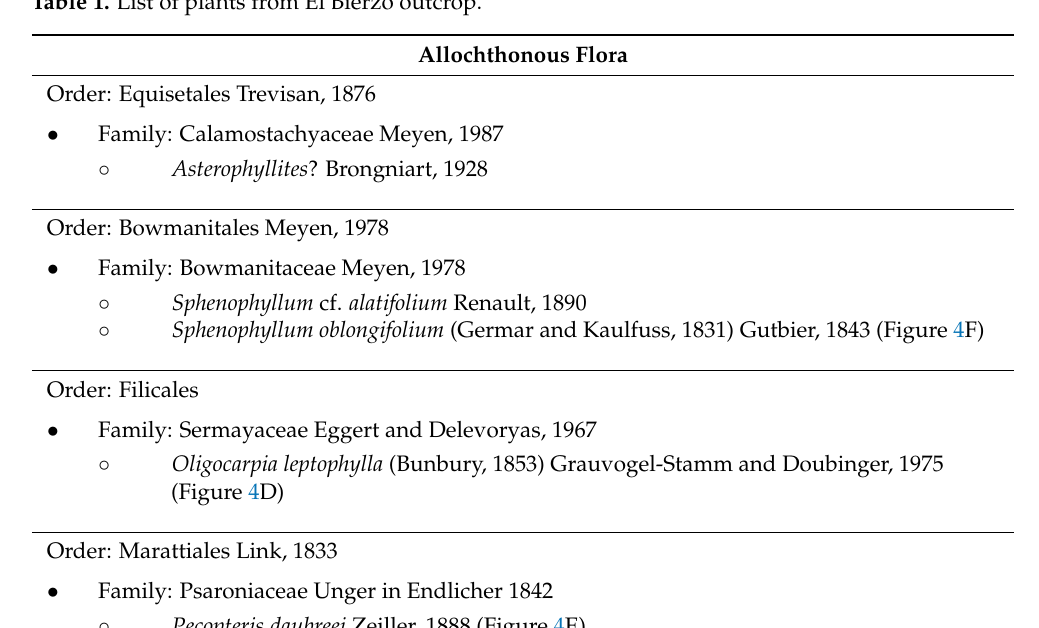
Table 1. List of plants from El Bierzo outcrop.